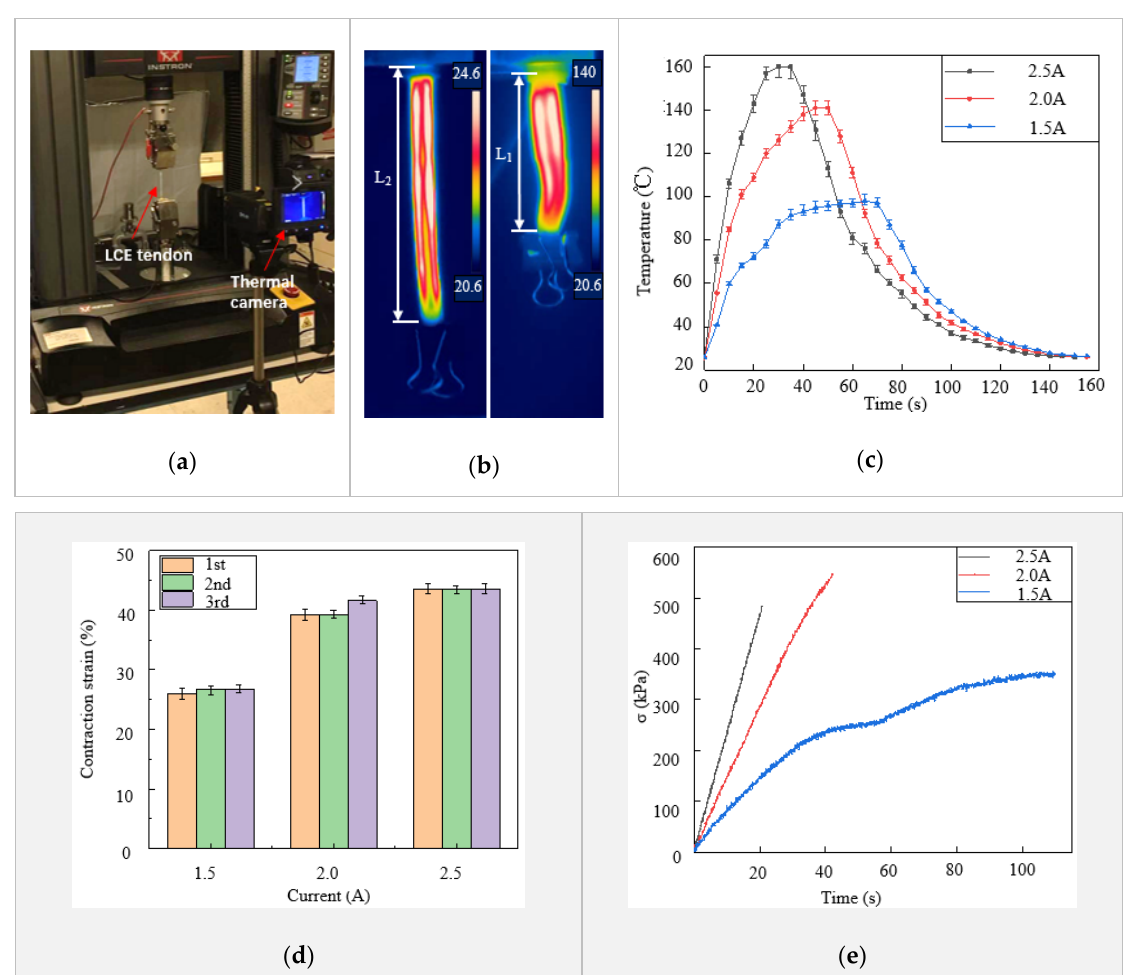
Figure 1. Design and fabrication of LCE tendon and biomimetic prosthetic hand. Comparison of the design and structure between ( a ) a robot hand [1], ( b ) a human hand [87], and ( c ) the biomimetic prosthetic hand. ( d ) The design and multilayer structure of the LCE tendon. ( e ) Programming of the LCE tendon during fabrication process.